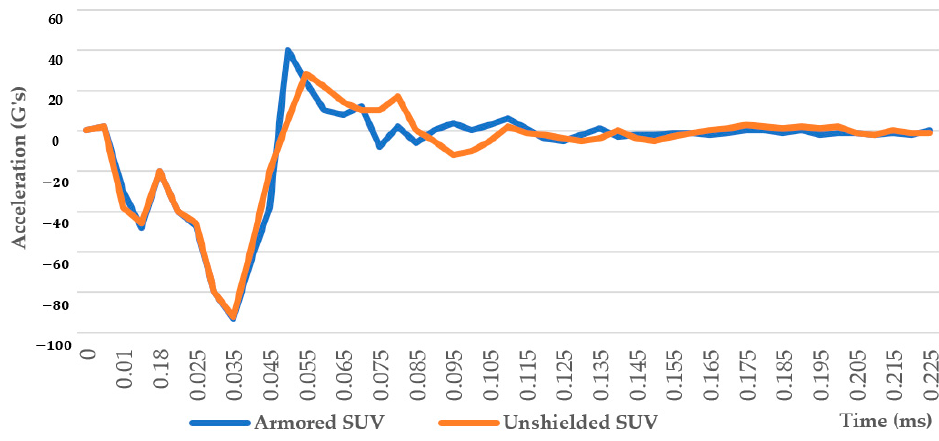
Figure 12. Acceleration in a frontal collision of the original SUV vs. the armored SUV.